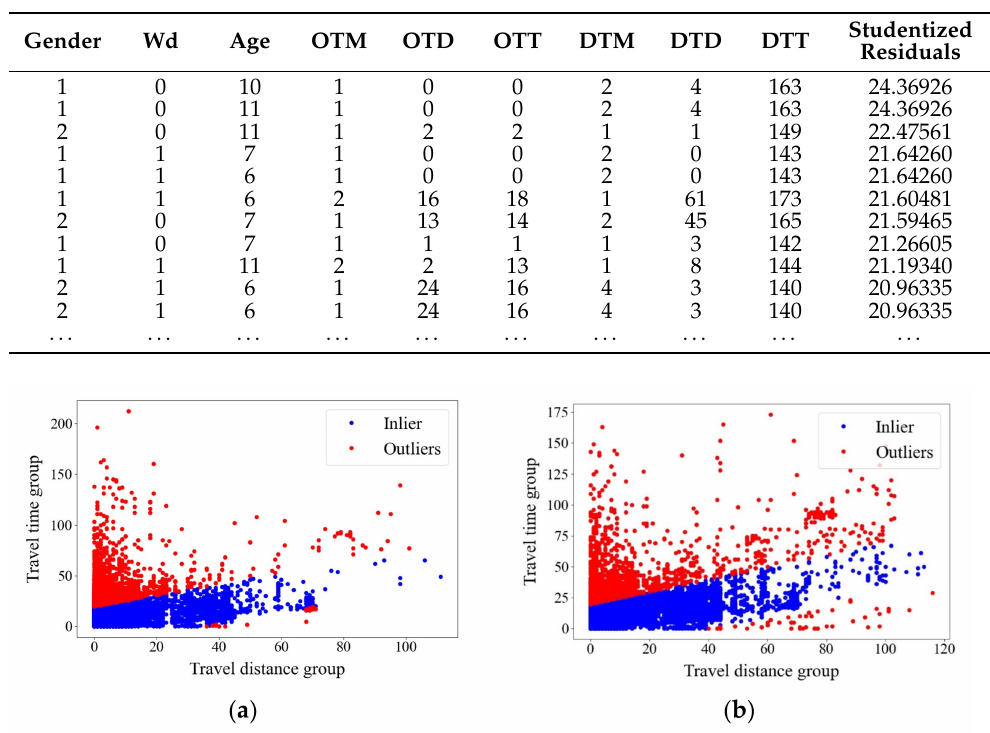
Table 6. Identification of abnormal value based on the variables of destination travel distance and time (May 2021).